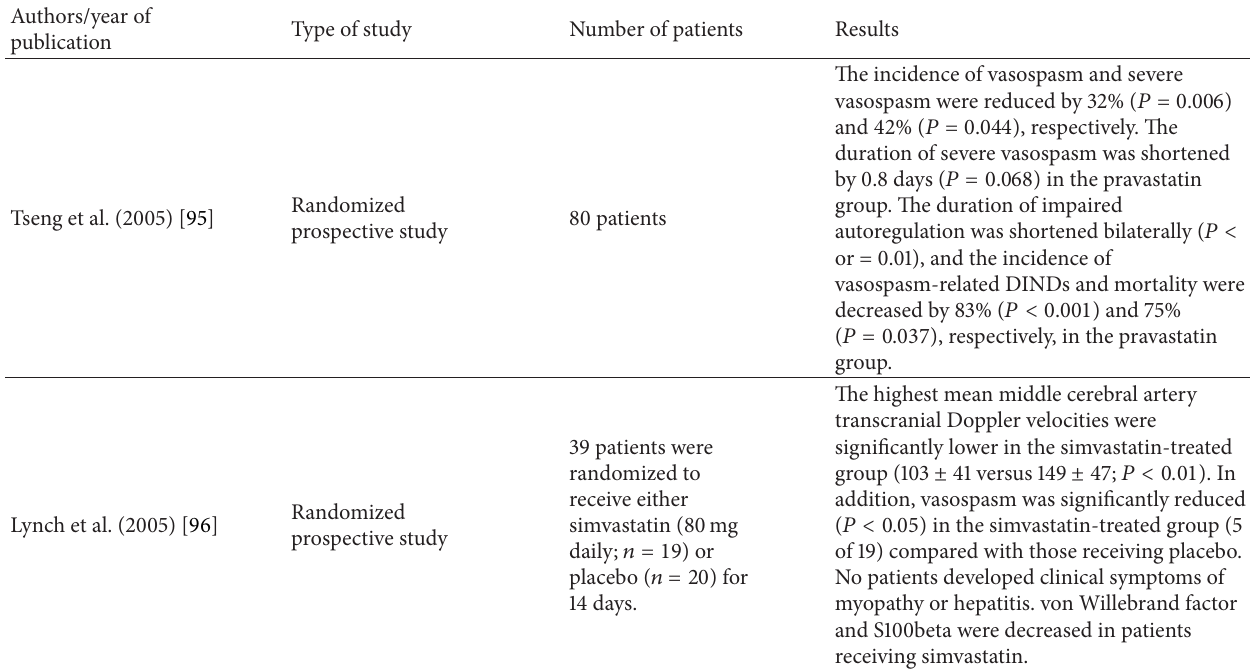
Table 3: Summary of clinical data regarding statins in the management of cerebral vasospasm.